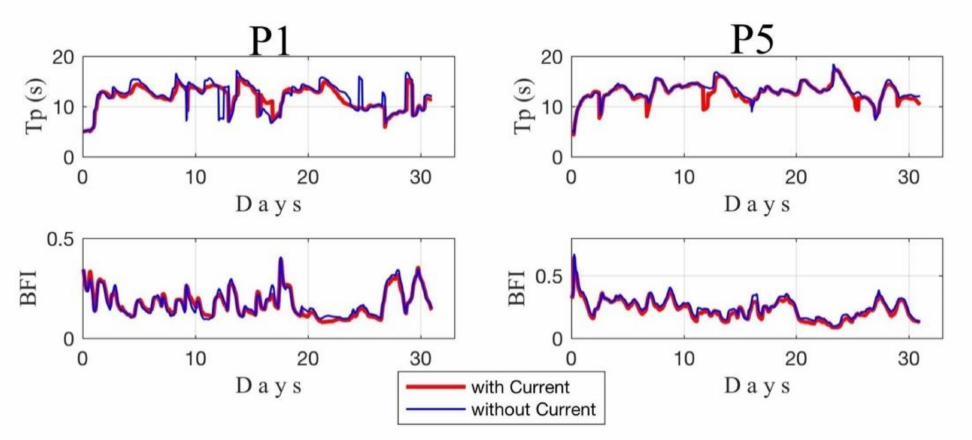
Figure 7. Evolution of the Peak Period (Tp) and BFI at P1 and P5 showing the decrease of the Tp some hours before the increase of the